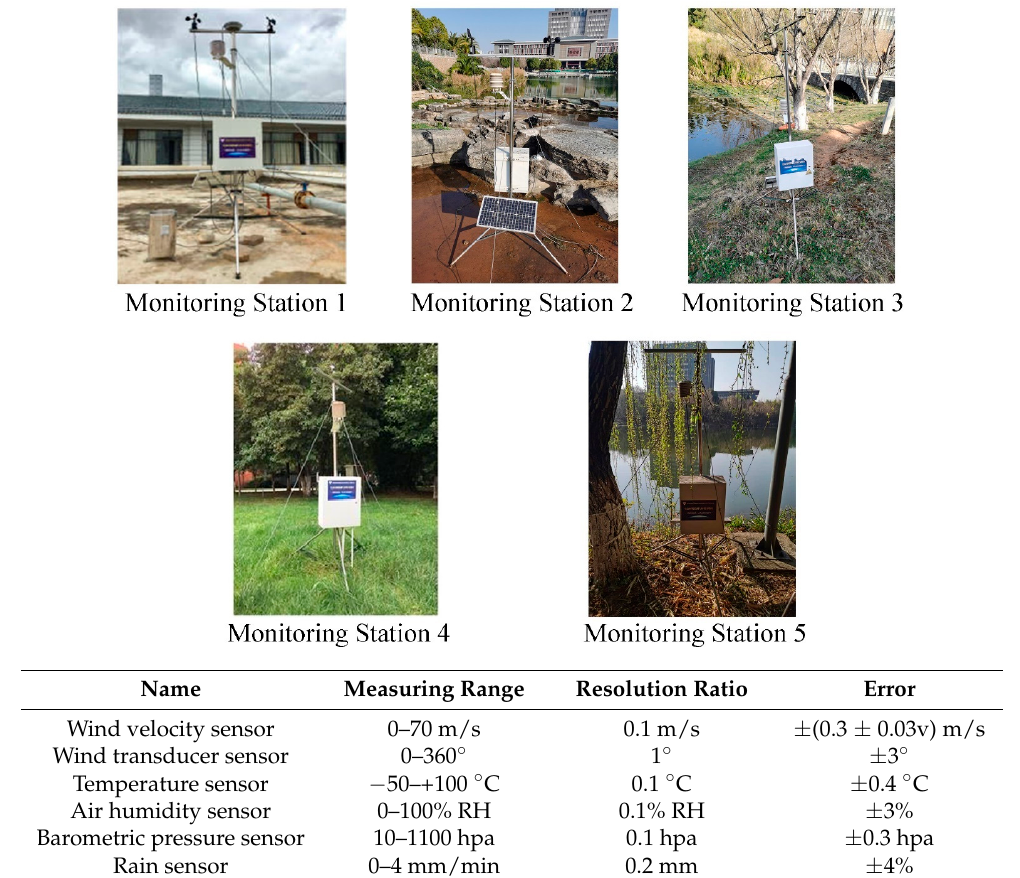
Table A1. Thermal environment monitoring station sensor parameters: monitoring per minute.